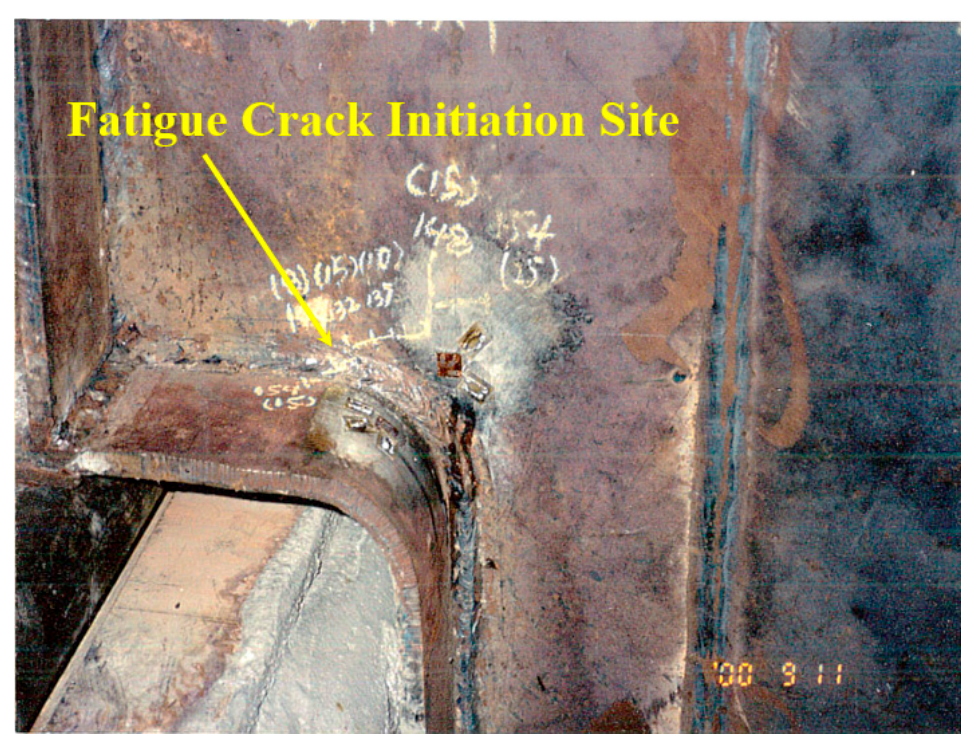
Figure 10. Cracks originated at the weld toe on the